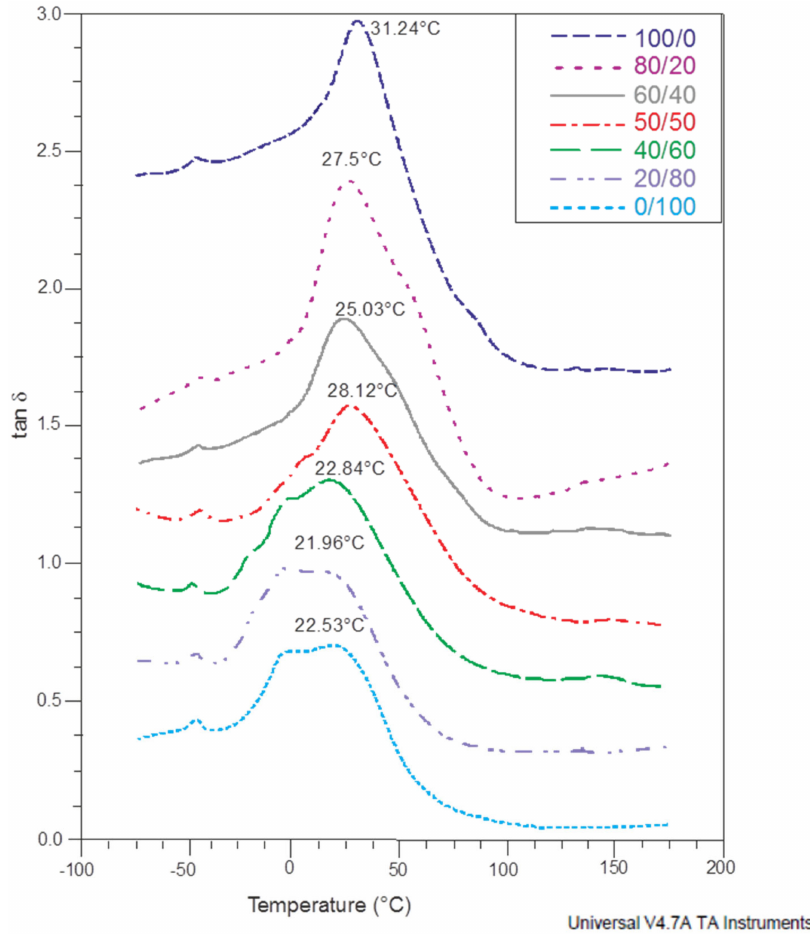
Figure 8. The dynamic mechanical thermal analyses (DMTA) curves of CMS / CMC